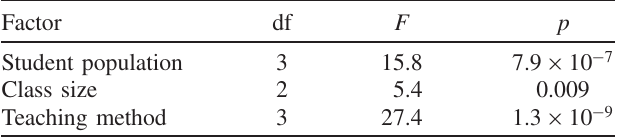
TABLE II. Results of three-way type 1 ANOVA comparing the affect of student population, class size, and teaching method on shifts on the CLASS and MPEX. All three factors were significant at the p < 0 . 01 level. The three- and two-way interactions were not significant. “ df ” ¼ degrees of freedom.